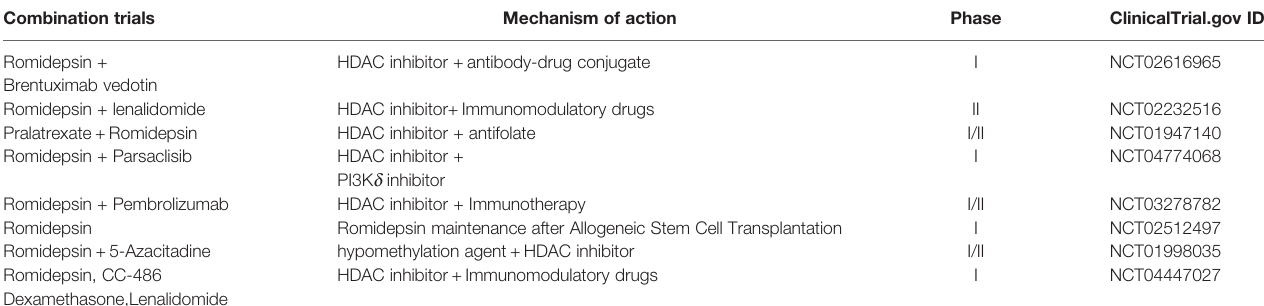
TABLE 2 | HDACi combination therapies under investigation are recruiting for relapsed/refractory cutaneous T-cell